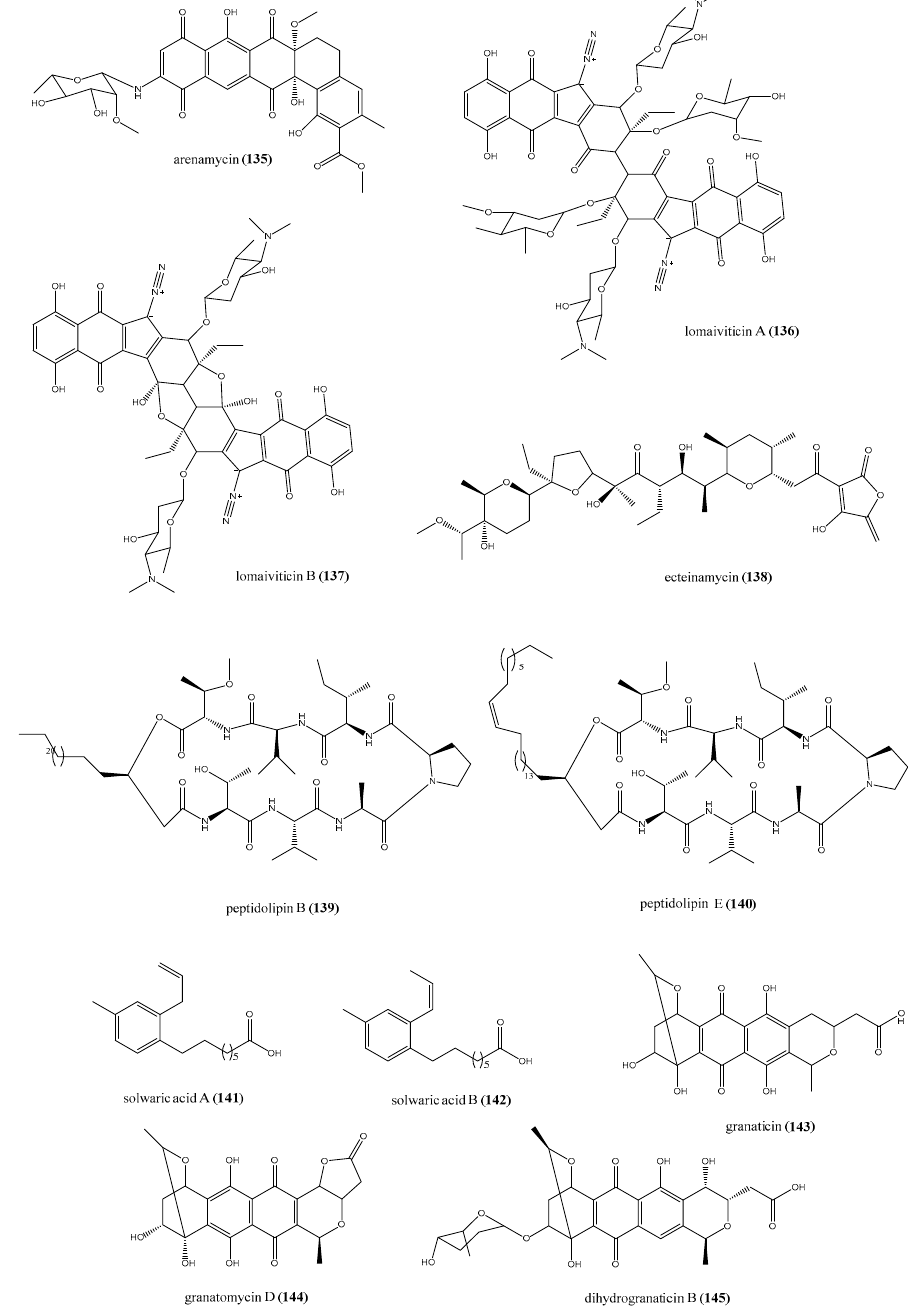
Figure 14. Structures of compounds 135 – 145 derived from ascidian-associated actinobacteria.